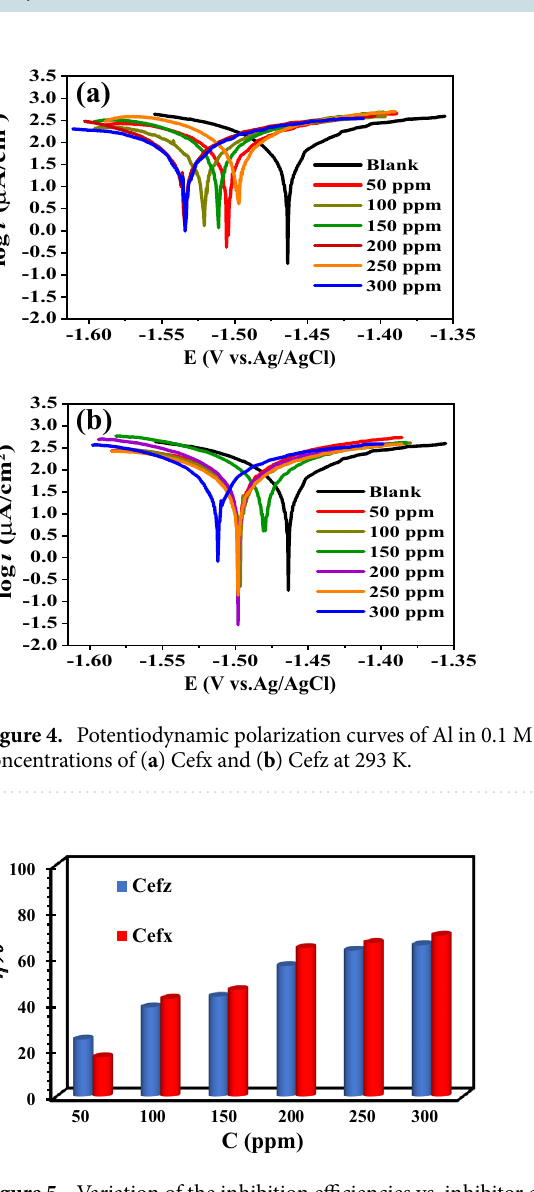
Figure 5. Variation of the inhibition efficiencies vs. inhibitor concentrations depending on the potentiodynamic polarization measurements at 293